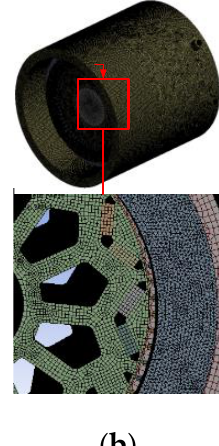
Figure 5. CFD model and mesh generation. ( a ) CFD model. ( b ) Mesh.